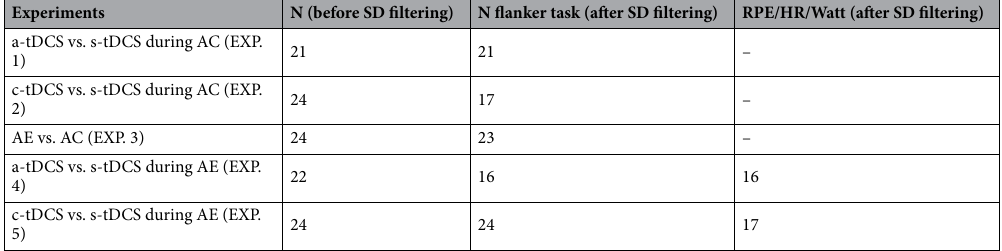
Table 5. Sample sizes before and after SD filtering and drop-outs for Flanker task and performance-related measures. AC = active control, AE = aerobic